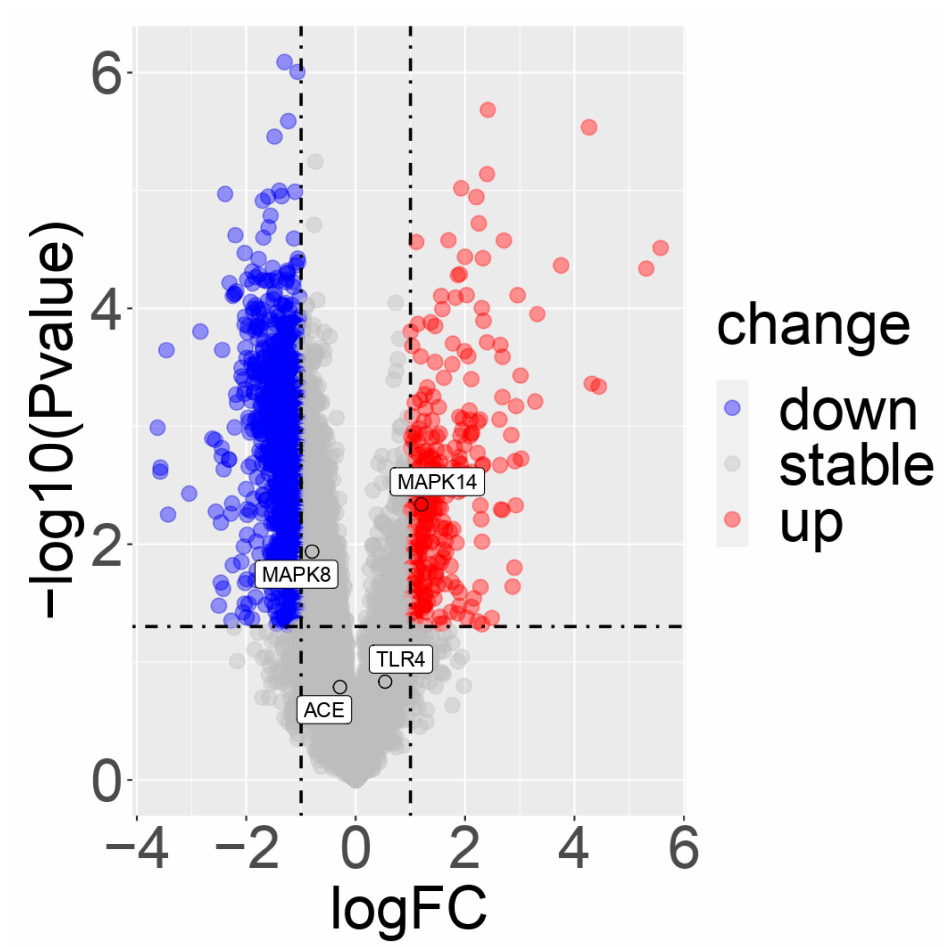
Figure 10. Volcano plots encode the 4 COVID-19-associated gene expression levels in COVID-19- infected whole blood tissue transcriptome datasets. Scattered balls encode genes. The x-axis indicates the log2 fold change levels between HC and COVID-19-infected, whereas the y-axis is adjusted p -value based on –log10. The plots indicate that the players were dysregulated after the SARS-CoV-2 infection. Red color—up-regulation, blue color—down-regulation, gray color—stable/non-significant. Genes revealed the differentially expressed players in accordance with significant